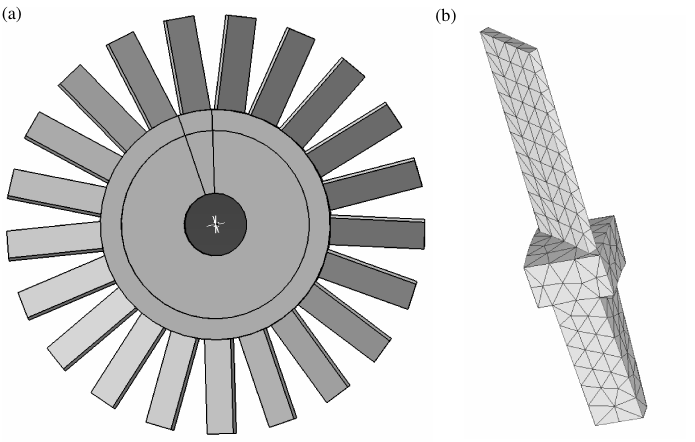
Figure 10. Rotor B with 21 blades and approximately 3600 DOF per sector: ( a ) Blisk model. ( b ) Sector mesh.